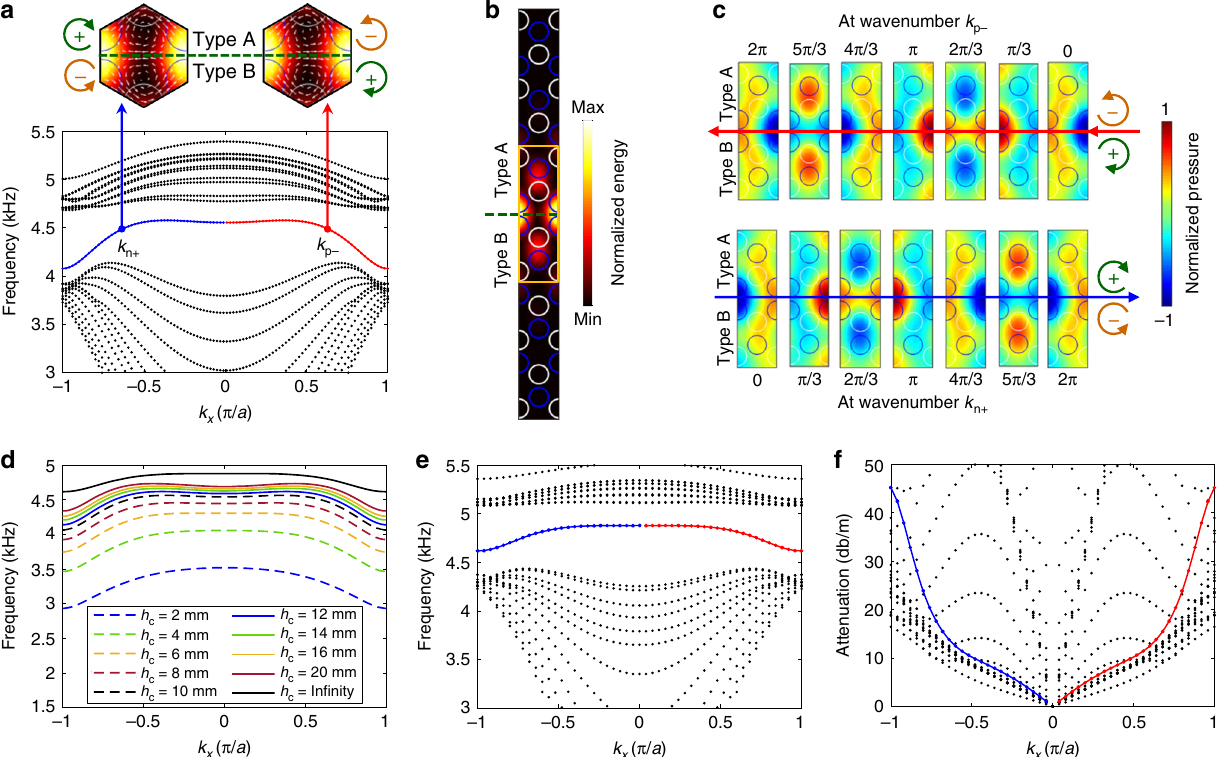
Fig. 2 Acoustic valley Hall edge states and their dispersion curves. a Dispersion curves for the type A – B supercell, when the channel height is 10 mm and the deep and shallow cavity depths are 10 and 13 mm. The red and blue solid lines are dispersion curves for the edge mode with positive and negative wavenumbers. The black dotted lines are in the bulk bands. Inset: edge states at wavenumbers of k p − and k n + . The color and arrows indicate acoustic energy and intensity, respectively. b Acoustic energy fi eld in a supercell with an A – B interface, when the wavenumber is k p − or k n + . c Evolution of acoustic pressure fi elds from 0 to 2 π in the vicinity of the A – B interface. The top and bottom fi elds are for k p − and k n + , respectively. The blue and white circles in c represent cavities in with depths of 10 and 13 mm. d Evolution of the edge mode dispersion with respect to channel height h c . With the increase of the channel height, the edge mode frequency for waveguide acoustic waves (WAWs) gradually increases and approaches to that for surface acoustic waves (SAWs). e , f Frequency and attenuation curves for the SAW-type edge mode, when the channel height is in fi nity. The attenuation is related to the leakage of SAW energy into the semi-in fi nite air medium above the cavities. The imaginary parts of wavenumbers for the SAW-type edge mode are plot in Supplementary Fig.